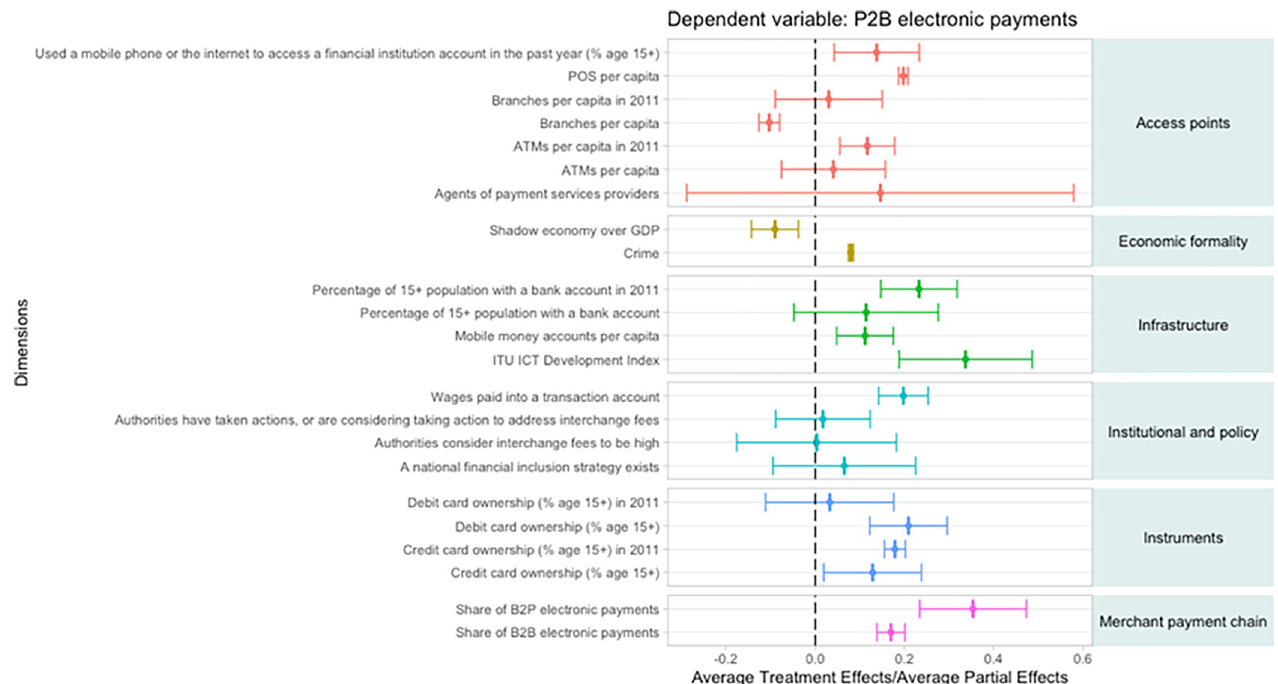
Fig 3. Treatment effects on the share of P2B electronic payments (country-level